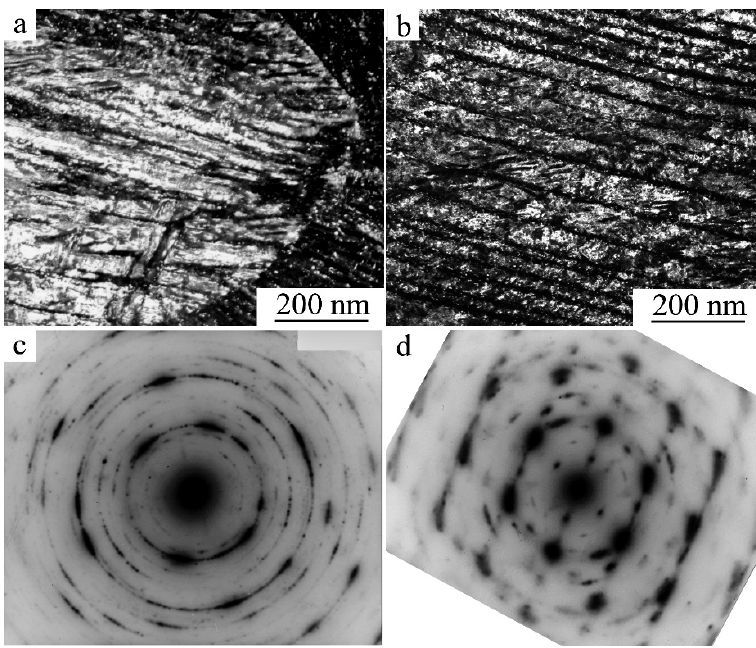
Figure 9. ( a ) Bright- and ( b ) dark-field TEM images of the microstructure, and ( c , d ) the corresponding SAED patterns (z.a. типа <110> B19’ , ( c ) SD 1.0 µm, ( d ) SD 0.3 µm), of the CG Ti 49.4 Ni 50.6 alloy after straining (to ~40%) [73].